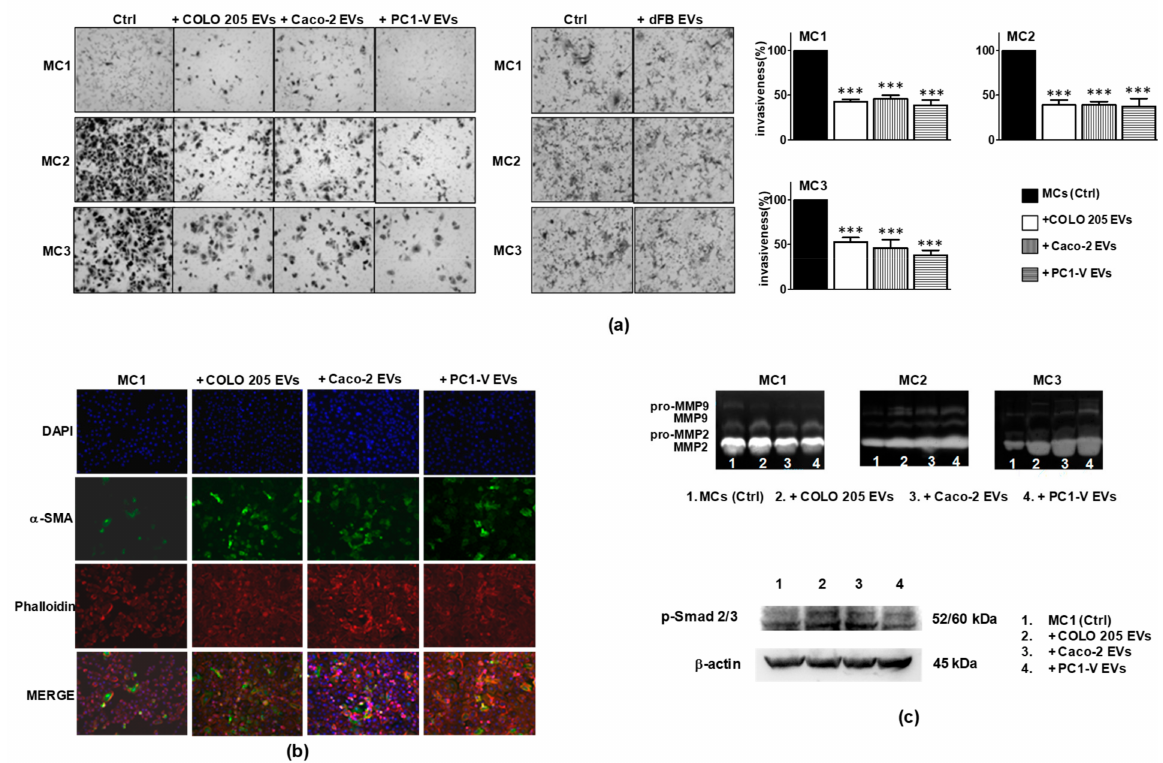
Figure 5. Tumor EVs enhance MMT and reduce the motility of mesothelial cells. ( a ) Representative images of optical microscopy showing reduction of MC1, MC2, and MC3 motility with COLO 205 EVs, Caco-2 EVs, and PC1-V EVs, MC1-3 invasiveness undisrupted by dFB EVs (magnification × 100) and quantification of mesothelial cell invasion % (*** p < 0.001 relative to control). Each value reported in the histograms is the mean ± SD of three different experiments performed in triplicate. ( b ) Representative images of fluorescence microscopy showing the increment of α -SMA (green) expression in phalloidin stained-MC1 (red) cells after the addition of COLO 205 EVs, Caco-2 EVs, and PC1-V EVs. Nuclei are counterstained with Dapi (blue) (magnification × 100). ( c ) Representative gelatin zymography showing that the addition of COLO 205 EVs, Caco-2 EVs, and PC1-V EVs to mesothelial cell lines increased the secretion of both pro-MMP-2/MMP-9 and active MMP-2/MMP-9, especially by MC2 and MC3 cell lines. Representative immunoblots showing the increase in p-Smad2/3 protein expression in MC1 treated with COLO 205 EVs, Caco-2 EVs, and PC1-V EVs. β -actin is used as loading